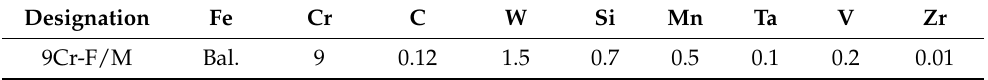
Table 1. Chemical composition (wt.%) of the 9Cr-F/M